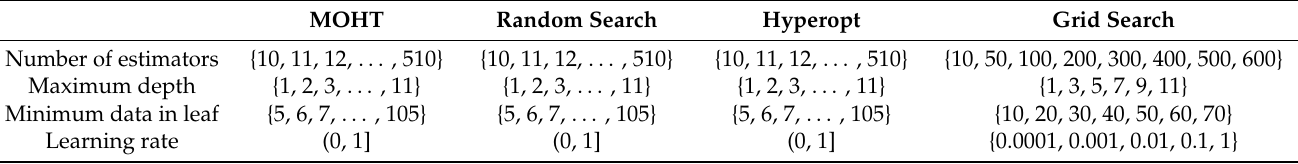
Table 3. Set of hyperparameters for various hyperparameter tuning techniques. MOHT Random Search Hyperopt Grid Search Number of